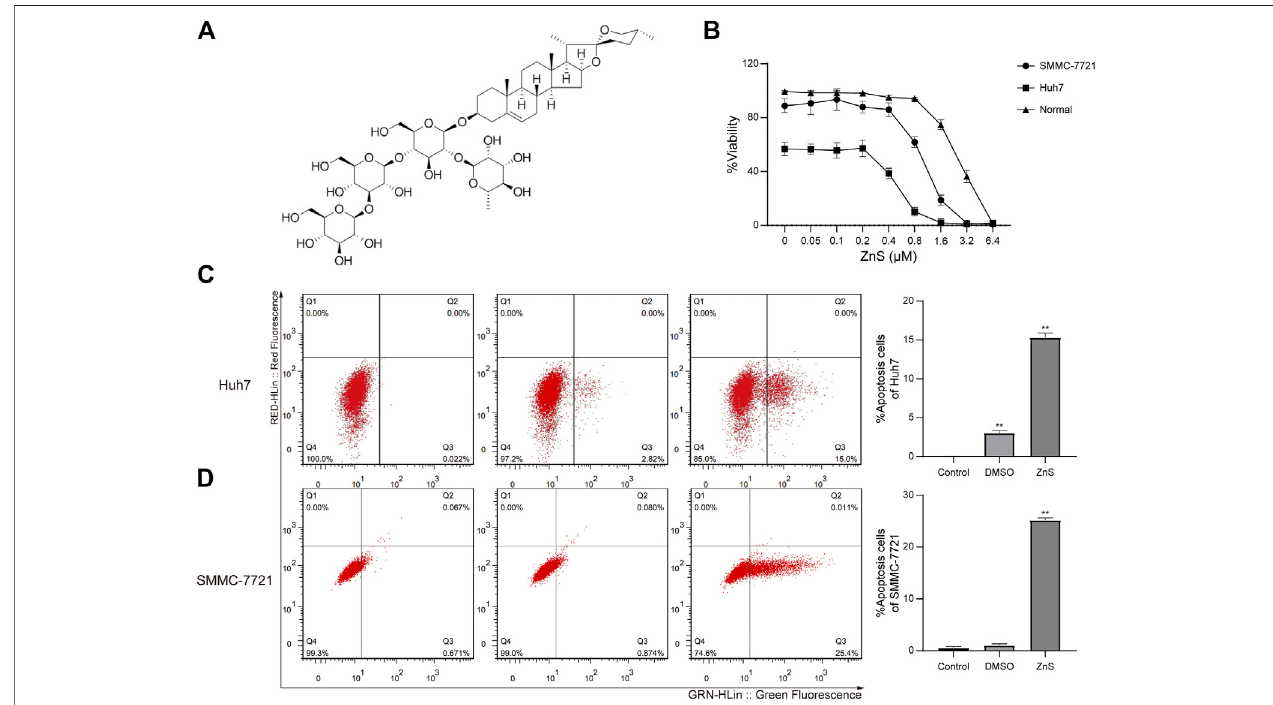
FIGURE 1 | (A) The chemical structure of ZnS. (B) The viability rates of human normal liver cell line, HL-7702, and human HCC cell lines, Huh7 and SMMC-7721, treatedwithZnS,wereexaminedusingCCK-8.Detectionofapoptosisratesintwocelllines,Huh7 (C) andSMMC-7721 (D) ,afterZnStreatmentby fl owcytometry.Each trial was replicated at least three times. Data are expressed as mean ± SD, **, p <